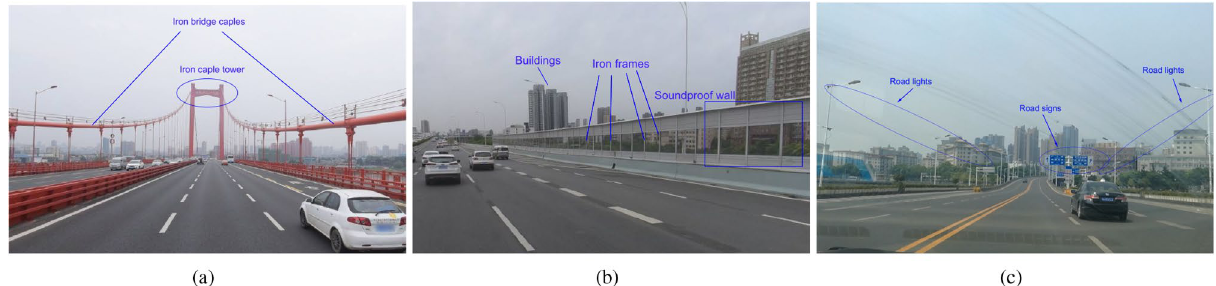
Figure 1. The measurement scenarios. ( a ) Iron bridge. ( b ) Soundproof wall. ( c ) Road